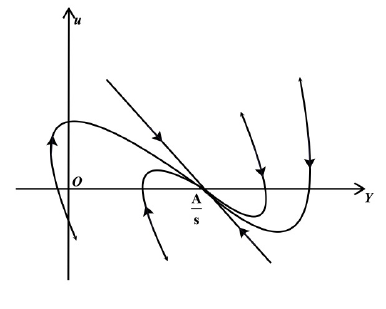
Fig. 8 Model under stable